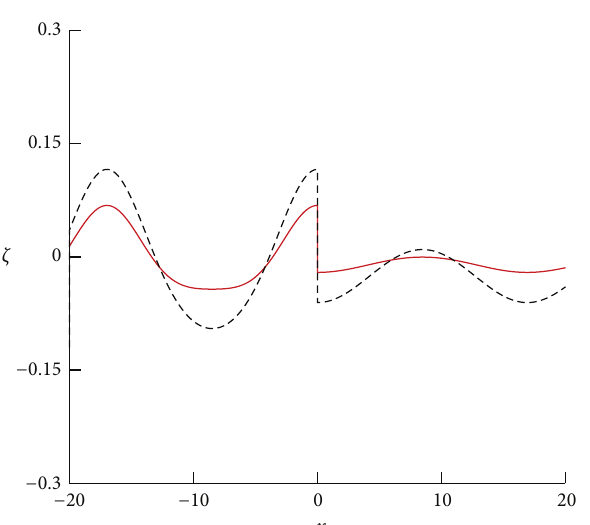
Figure 3: Comparison of my nonlinear wave profiles with those of corresponding linear theory. Solid line: linear solution; dashed line: nonlinear solution.